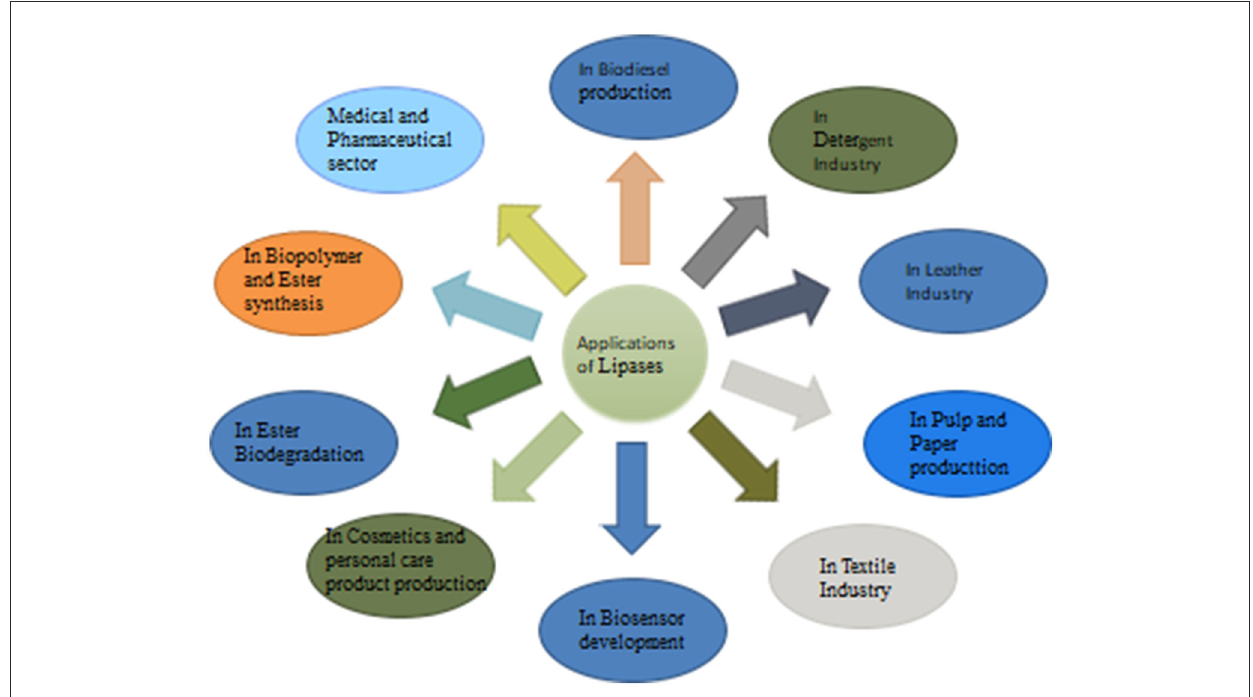
FIGURE2 Applications of fungal